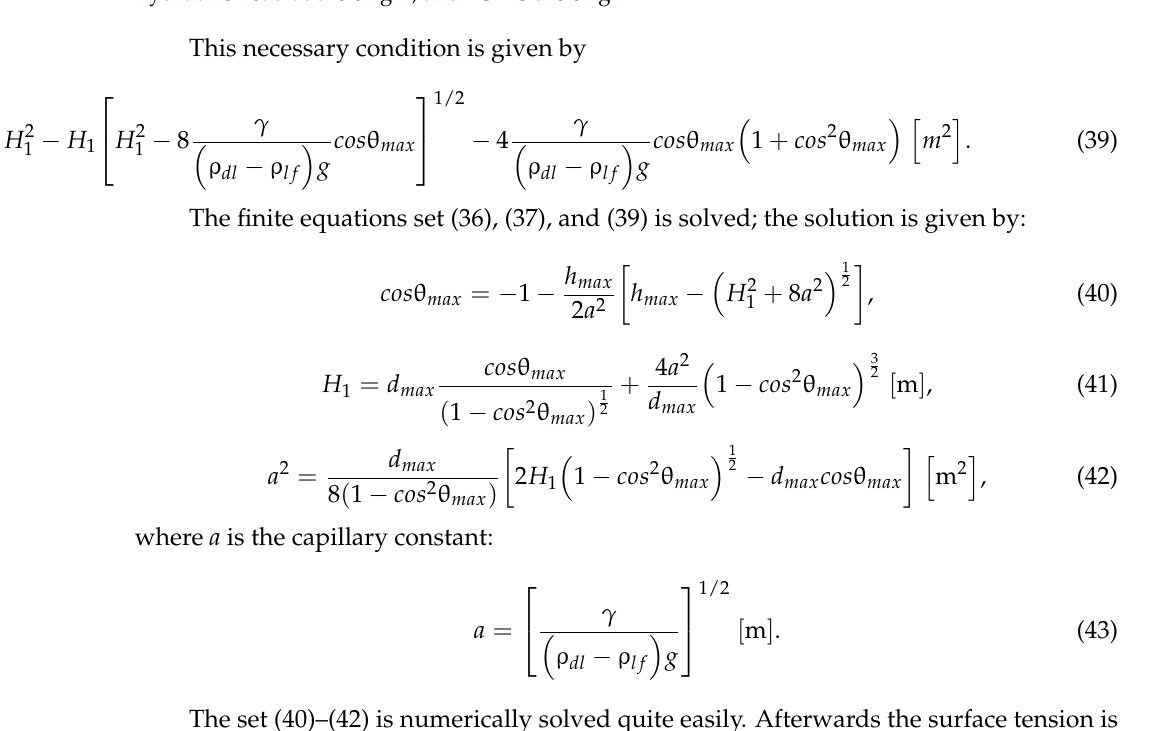
Figure 7. The new method for surface tension determination: d max is the maximal drop diameter; h max is the height between this diameter and the drop bottom; θ max and r max are the polar coordinates at the largest diameter; d max , x max , and z max are the Cartesian coordinates at this diameter; H 1 is the hydraulic head at the origin; and “O” is the